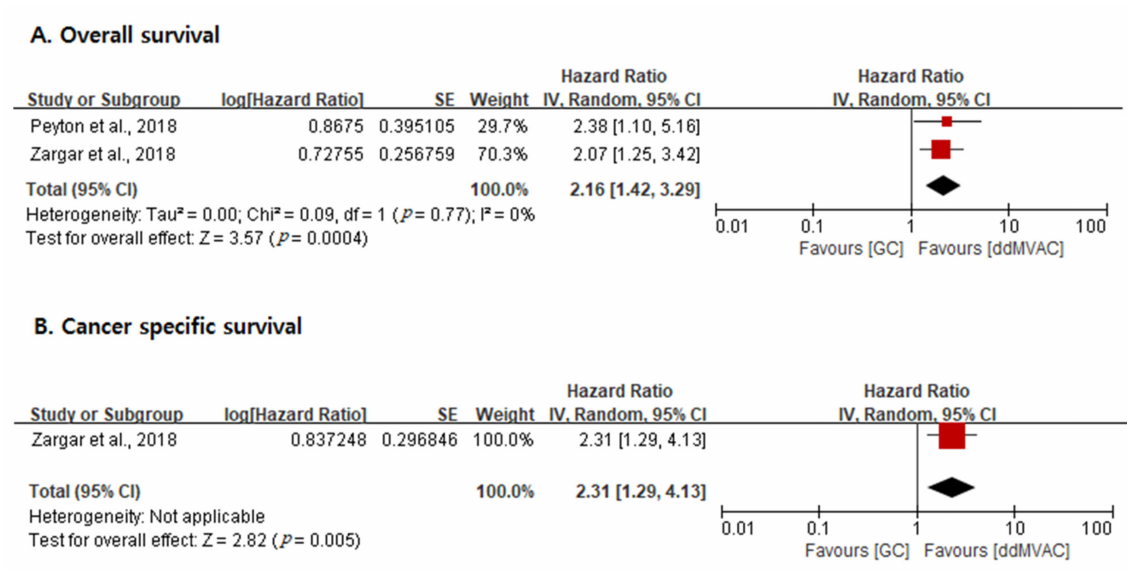
Figure 4. Forest plots of survival outcomes. ( A ): Overall survival. ( B ): Cancer-specific